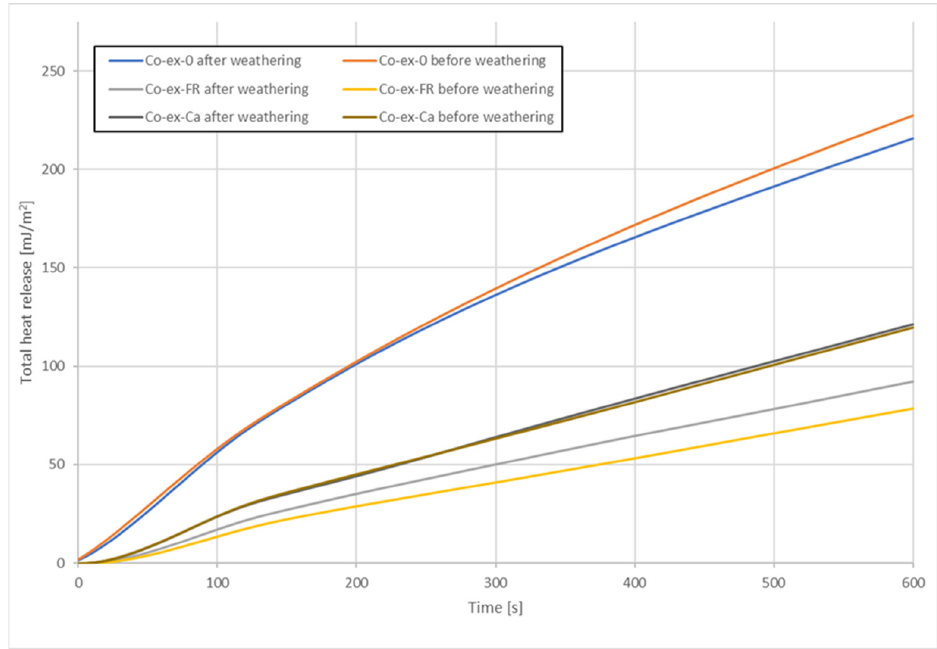
Figure 22. Total heat release for co-extruded formulations before and after weathering. 0: without any filler; FR: with FR CROS 490; and Ca: with calcium carbonate.